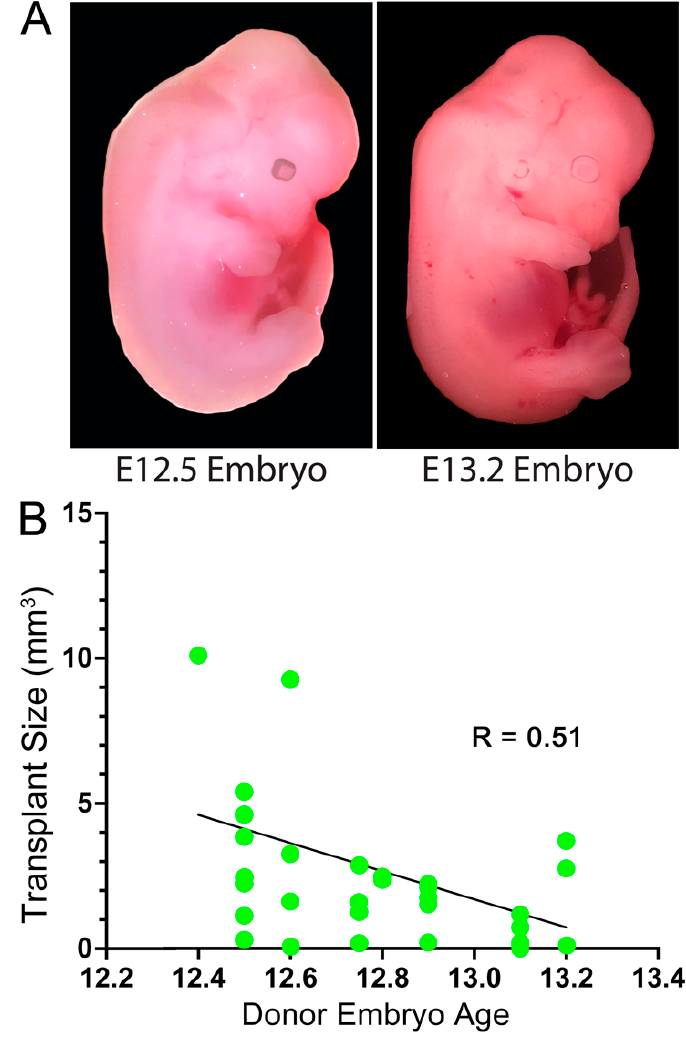
Figure 1. Size of transplants after 2 weeks correlated with the embryonic stage of the donors. ( A ) Example mouse embryos at the times of harvest. ( B ) Transplants within stroke sites are graphed according to the embryonic stage from which the donor cells were harvested. Each dot is a donor mouse. Spearman correlation, n = 32.